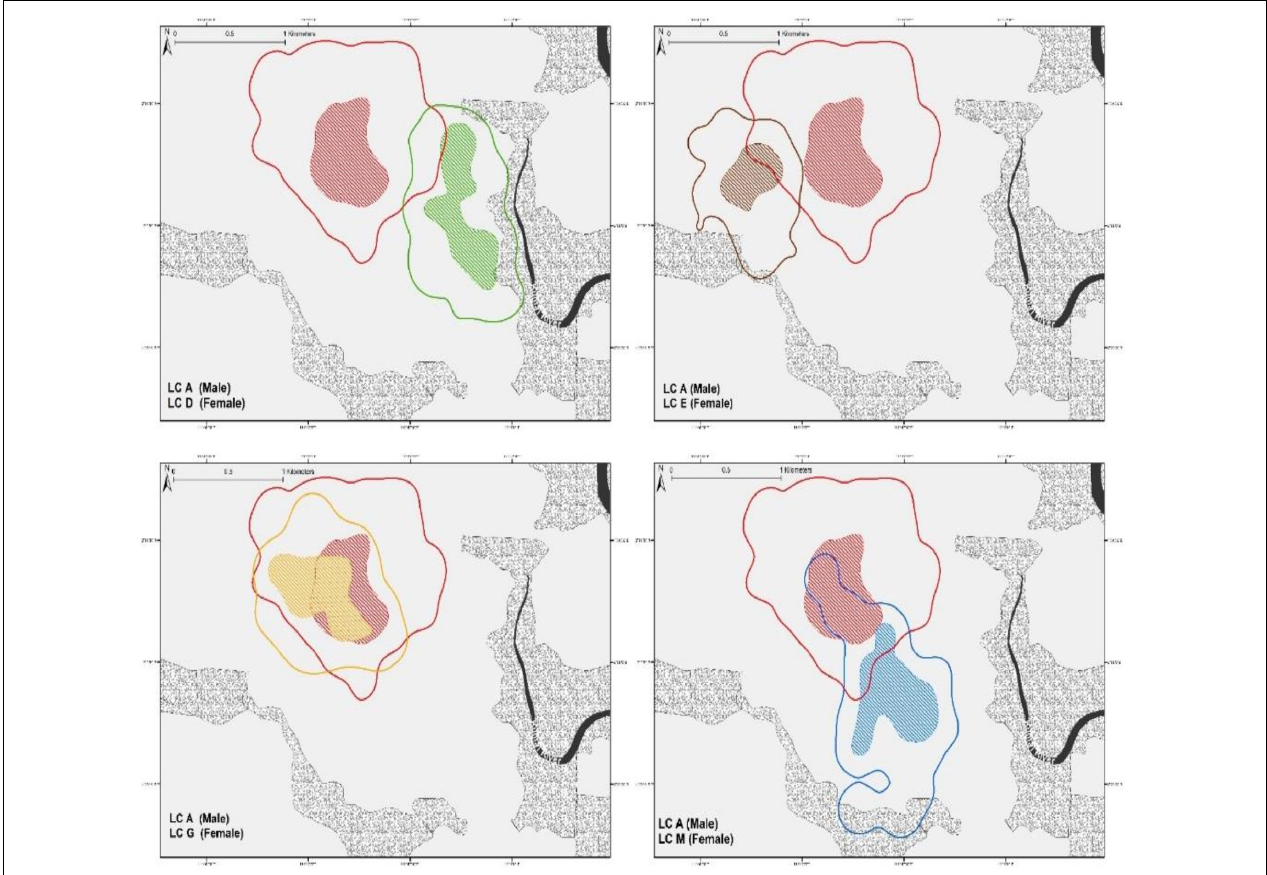
FIGURE 2 | Home range of male LC-A with overlapping females. Solid line illustrates 95%FK and color shaded indicates 50%FK. The proportion of LC-A overlap with sympatric females is subject to individual variation.